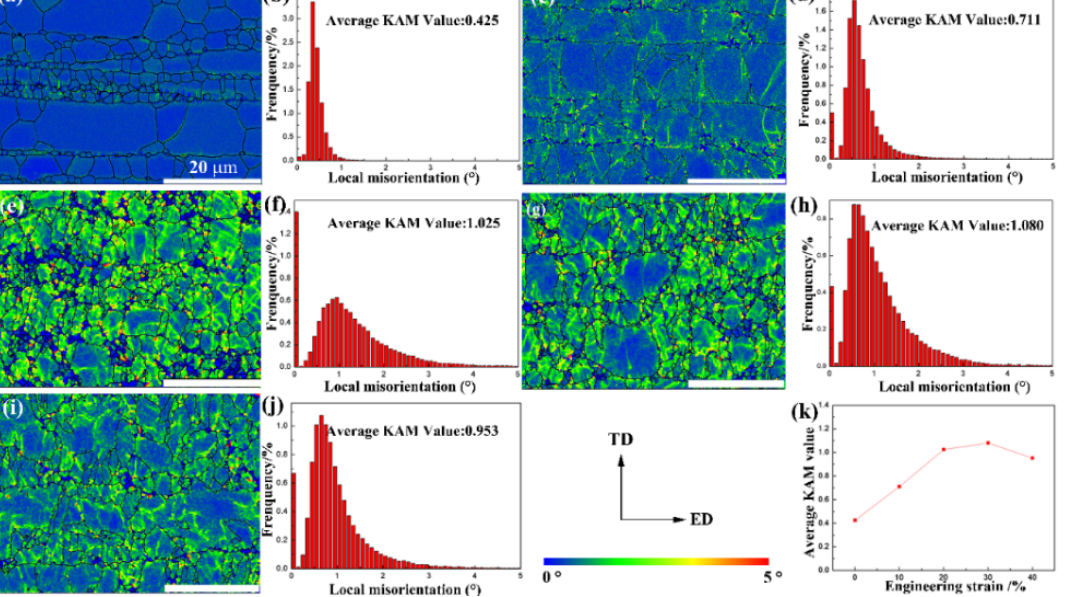
Figure 8. Kernel average misorientation maps and local misorientation angle distribution maps of as-extruded 0.05 wt.% ND/ZK60 composite with varied strains at the deformation temperature of 200 °C and the strain rate of 1 s −1 : ( a , b ) 0, ( c , d ) 10%, ( e , f ) 20%, ( g , h ) 30%, and ( i , j ) 40%, ( k ) line chart of average KAM value.